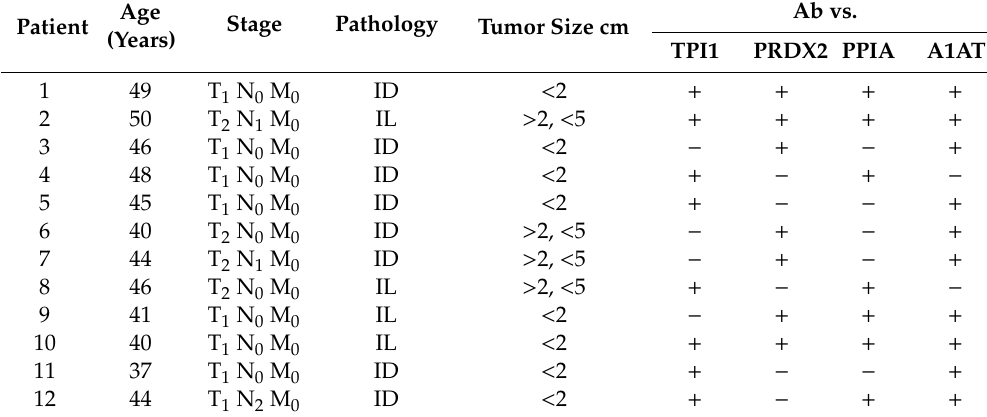
Table 1. Clinical characteristics of subjects with breast cancer and positivity.